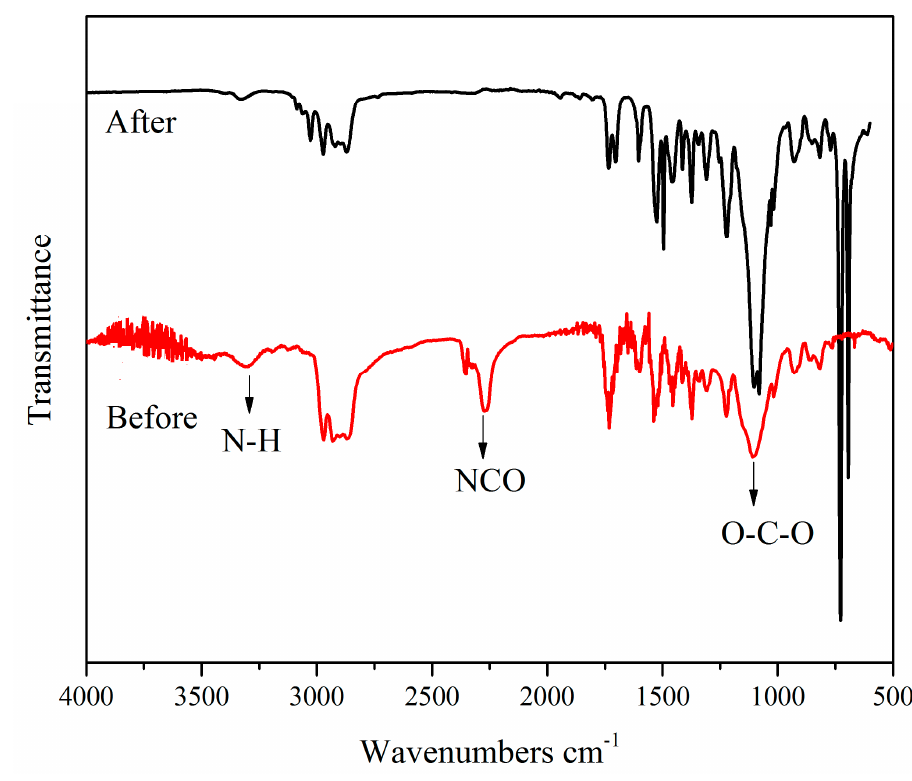
Figure 2. FTIR spectra of tung-oil-based polyurethane before (reactant mixture) and after the synthesis.